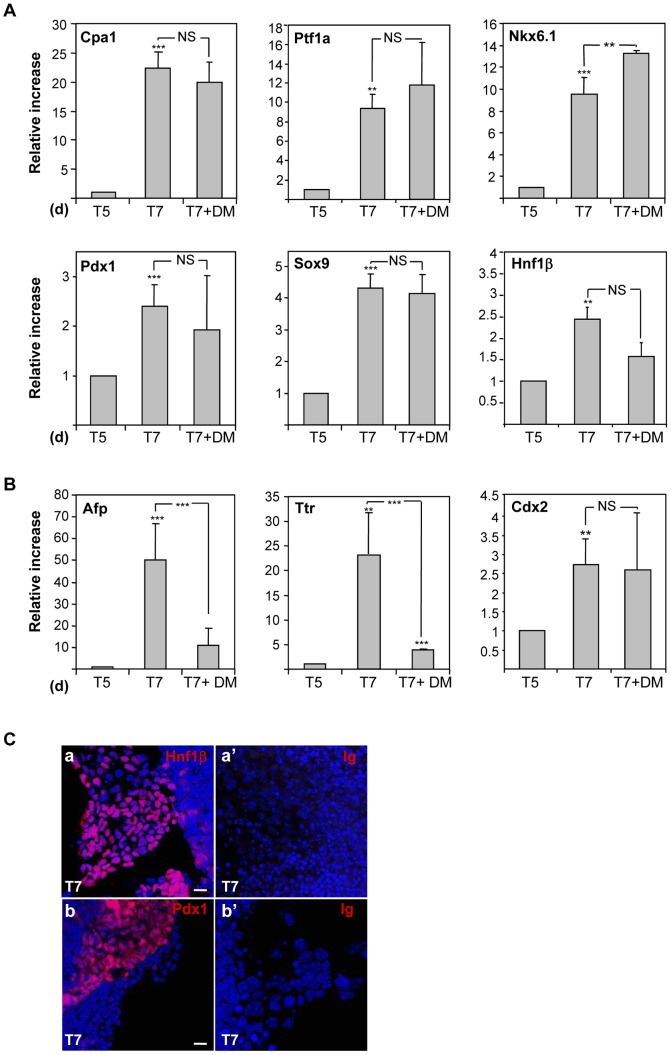
Expression of pancreatic progenitor markers at stage 2.A) Cells were induced to differentiate through progression of stages 1 and 2 with or without DM as indicated in Fig. 1. After 5 (stage 1) or 7 (stage 2) days, cultures were harvested and subjected to qRT-PCR analysis for the indicated markers. Histograms show the relative expression levels normalized to the loading control Hprt. Error bars indicate the standard deviations of 3 experiments. p values correspond to comparisons between T5 and T7 and between T7 and T7+ DM. NS, not significant. The effect of the pro-pancreatic agents was analyzed at the beginning and the end of the corresponding stage. B) Expression of non-pancreatic markers by qRT-PCR as indicated in A. C) Immunofluorescent staining for HNF1β (a) and Pdx1 (b) in 7-day cultures (stages 1 and 2), 12 hours after plating. Nuclei were stained in blue. The corresponding negative controls are shown in (a’) and (b’). Scale bars, 10 µm.